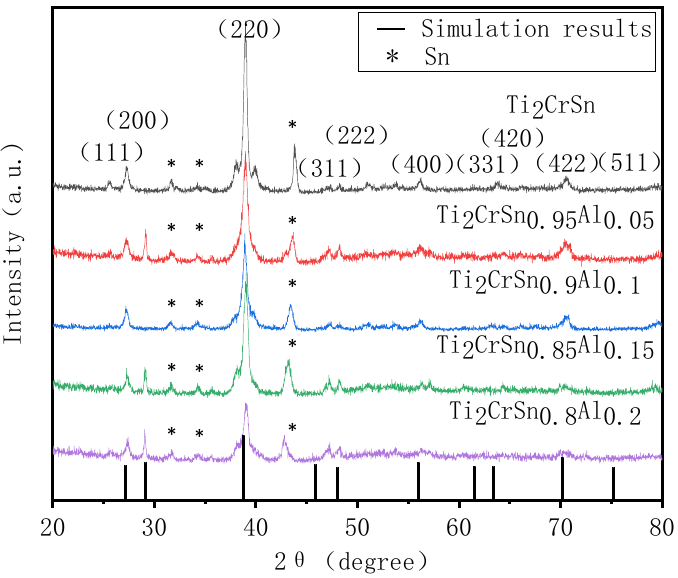
Figure 1. X-ray diffraction pattern of the Ti 2 CrSn 1-x Alx (x = 0, 0.05, 0.1, 0.15, 0.2) alloy.